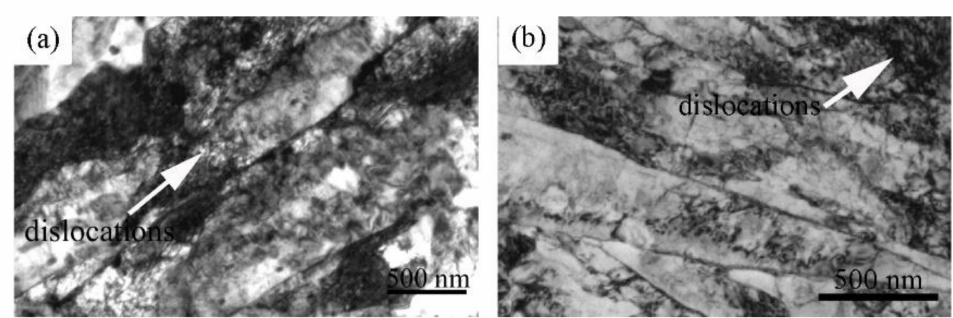
Figure 7. The TEM photographs of the specimen that experienced fatigue tests of 450 MPa for 10,000 cycles under magnetic field ( a ) and no magnetic field ( b ) of 1.2–1.3 T, revealing obvious dislocation